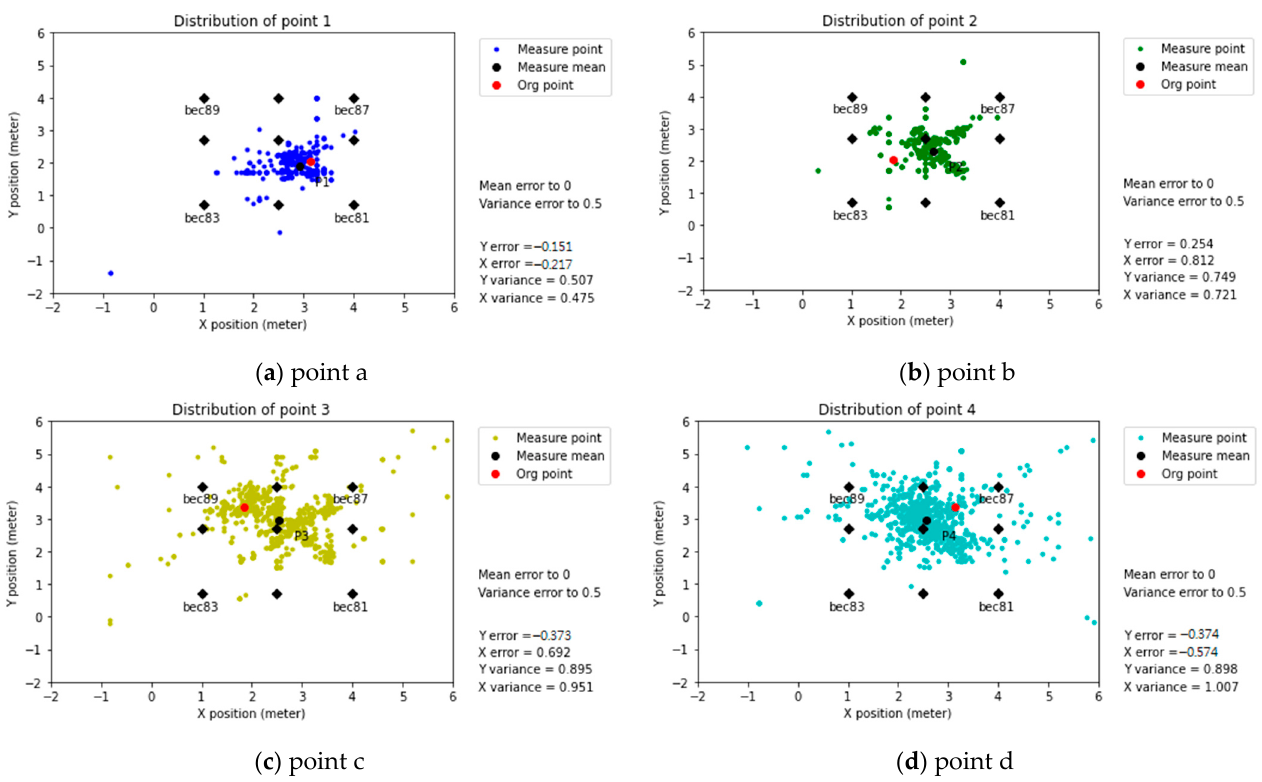
Figure 20. Predicted positioning (with modification coefficients), BLE 4.2 (Linkit7697).